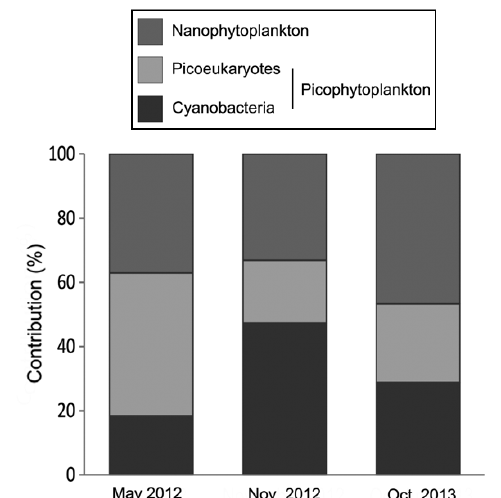
Fig. 5. Proportion of the 3 groups of phytoplankton in ambient seawater, expressed as a percentage of carbon biomass, for the 3 dates of the experiment